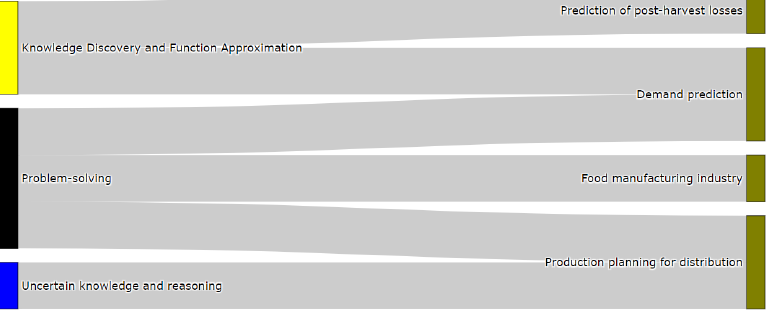
Figure 12. Processing problems classified by the proposed taxonomy.